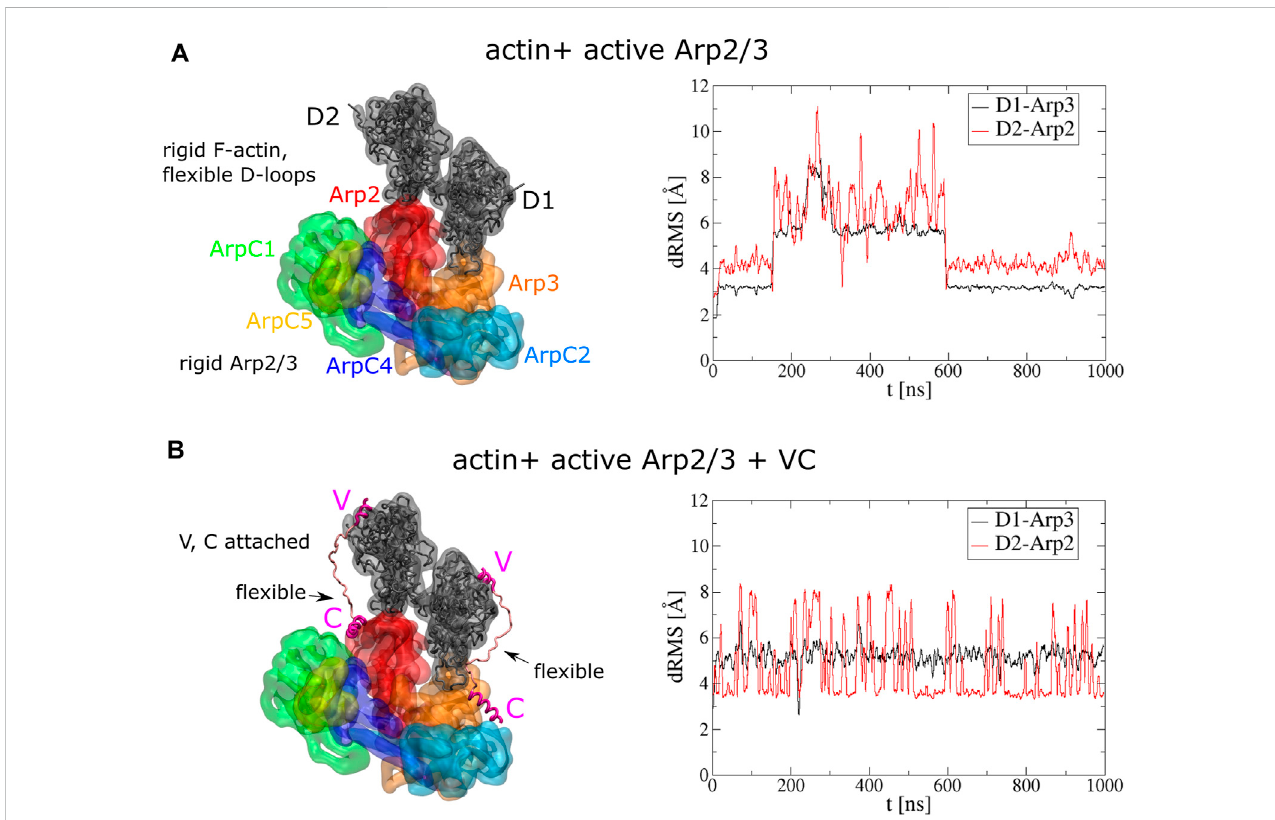
FIGURE 2 Stable binding of two actin subunits to active Arp2/3 complex. (A) Left: Initial conformations of serial simulation starting from two actins bound to Arp2 and Arp3 of active Arp2/3 complex. The ArpC3 subunit isn ’ t displayed. Right: dRMS of each actin with respect to Arp2 and Arp3 as function of time. (B) Left: Initial conformations of serial simulation starting from two actins bound to Arp2 and Arp3 of active Arp2/3 complex. Each actin has a V domain rigidly attached while the C helix is rigidly attached to Arp2/3 complex. Right: dRMS of each actin with respect to Arp2 and Arp3 as function of time. The simulations are performed in cubic boxes of side 300 Å for 1 μ